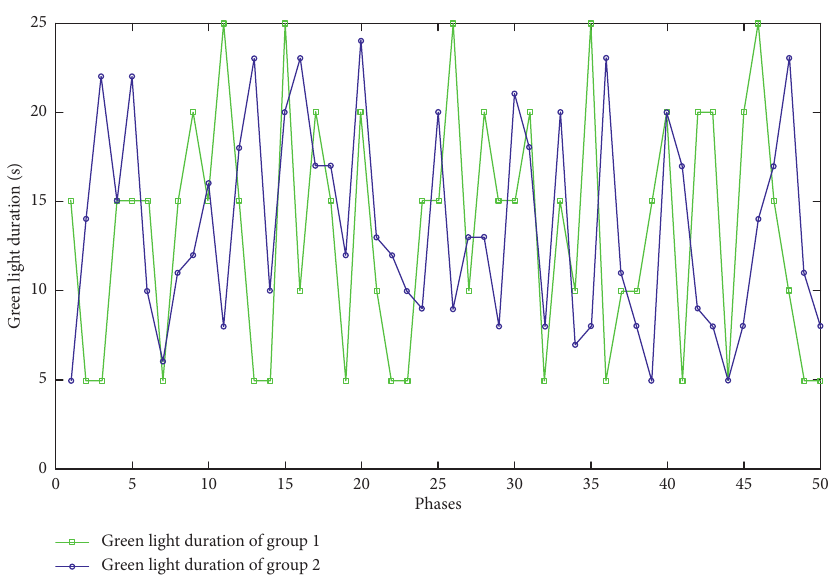
Figure 7: The green light duration of intersection 8 in groups 1 and 2.